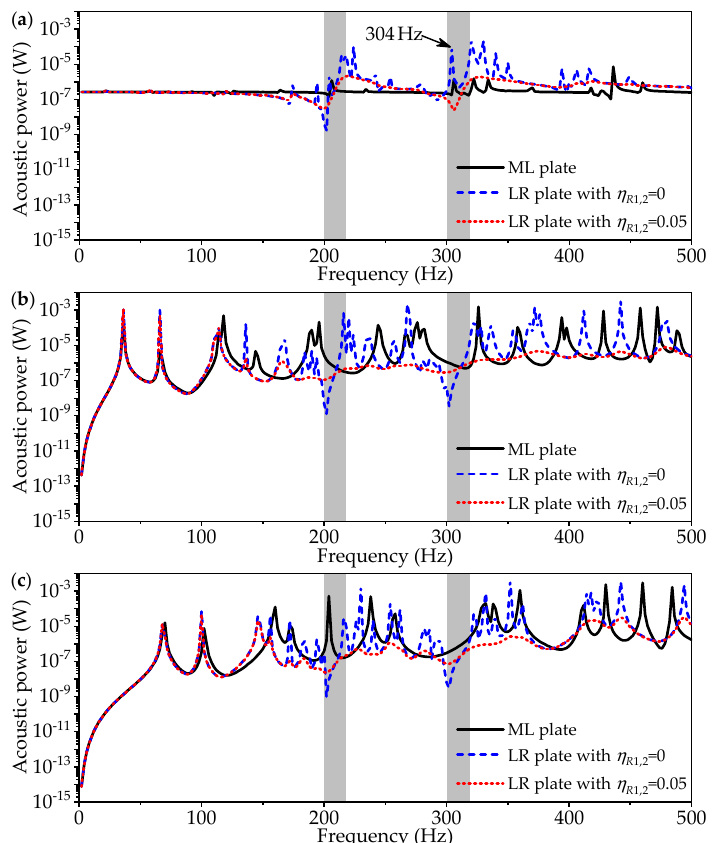
Figure 12. The acoustic power radiated from the mass-loaded (ML) plate, the locally resonant (LR) plate with undamped resonators ( η R 1,2 = 0), and the LR plate with damped resonators ( η R 1,2 = 0.05), with ( a ) fully free boundary conditions, ( b ) fully simply supported boundary conditions, and ( c ) fully clamped boundary conditions.